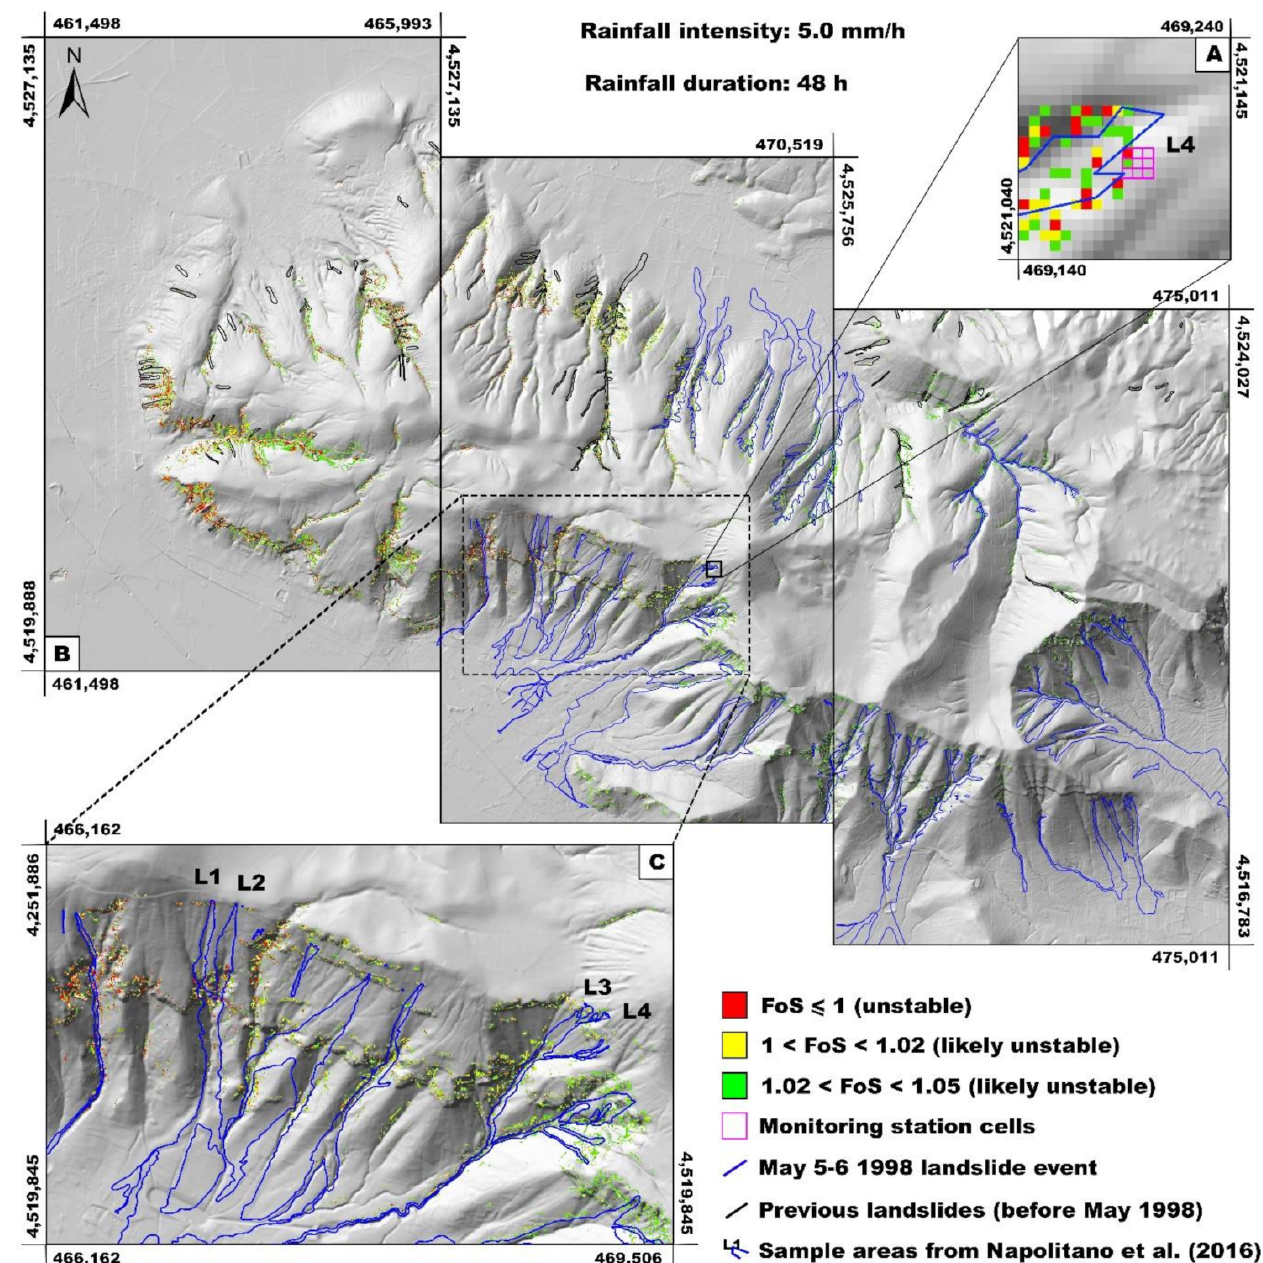
Figure 9. Distributed slope stability maps, at site–specific ( A ) and slope distributed ( B ) scales, resulting from a constant rainfall intensity of 5.0 mm/h with a duration of 48 h. Unstable and likely unstable cells were compared within sample areas ( C ) L1, L2, L3 [77], L4 and the entire Sarno Mountains landslide inventory comprising the May 1998 Sarno landslide event. Monitoring station cells used for local scale modeling and L4 threshold definition are also shown ( C ) (WGS84/UTM